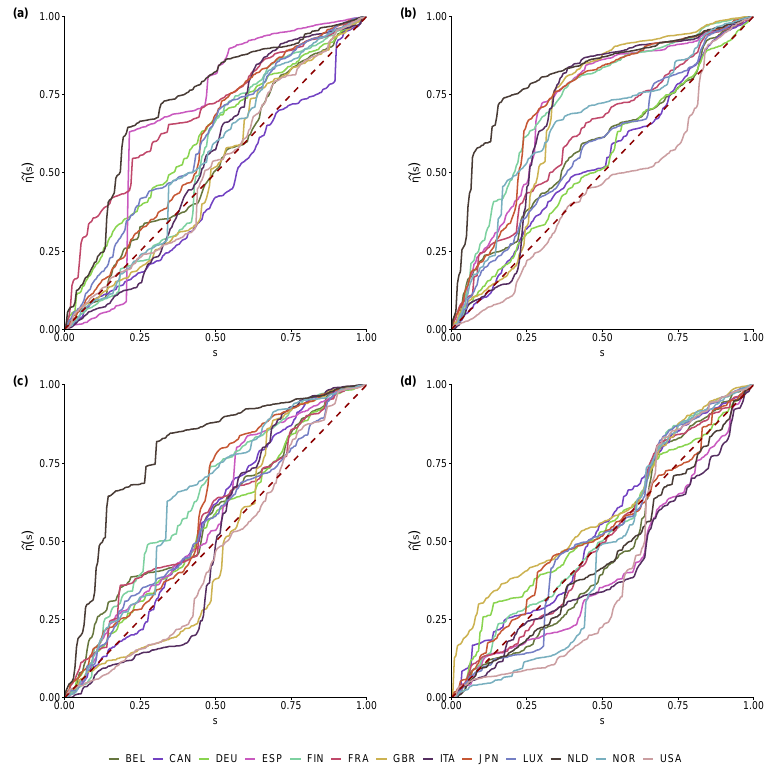
Figure 4. Estimated variance profiles for year-on-year inflation rates of selected OECD countries: ( a ) February 1957–September 1994, monthly CPI data from Culver and Papell (1997). Other panels: monthly CPI data from the OECD database for ( b ) April 1961–March 2019 ( c ) April 1961–December 1989 ( d ) January 1990–March